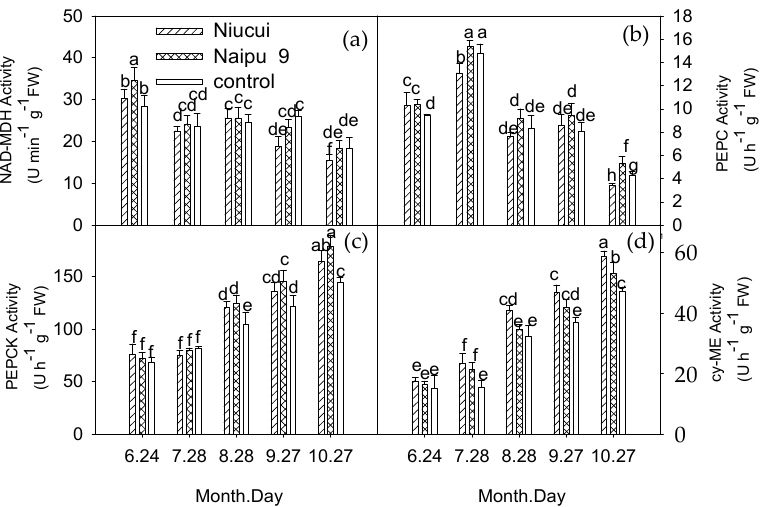
Figure 5. Effects of spraying calcium fertilizer on ( a ) NAD-MDH activity, ( b ) PEPC activity, ( c ) PEPCK activity, and ( d ) cyME activity of apple fruit. The values represent mean ± S.E. of three replicates. Bars indicate S.E. Bars with the same letter were not significantly different at p < 0.05.